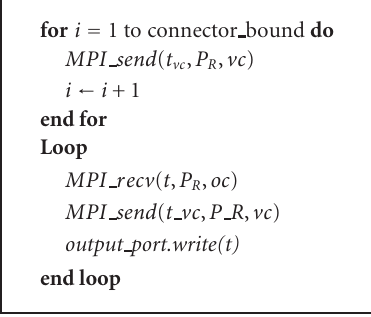
Algorithm 2: Receiver middleware task per incoming connector.